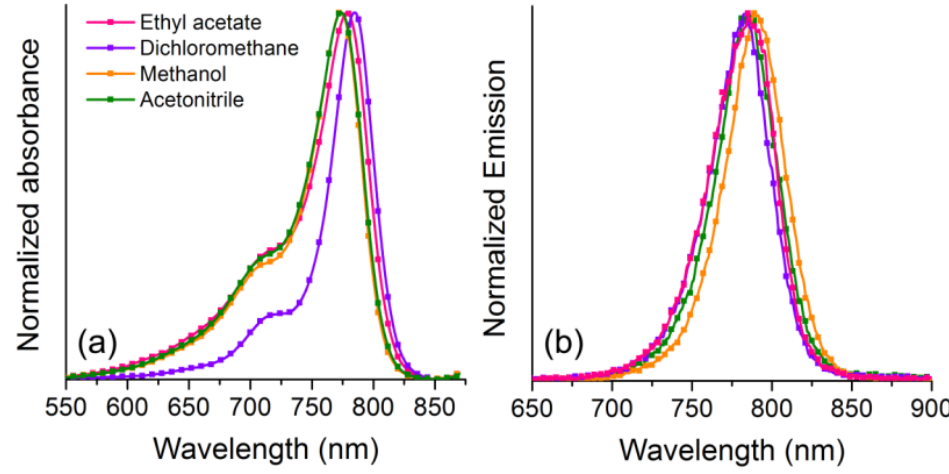
Figure 1. ( a ) UV-Vis absorption and ( b ) steady-state fluorescence emission spectra in solution of different organic solvents (~10 − 6 M) of the heptamethine cyanine dye 6a .